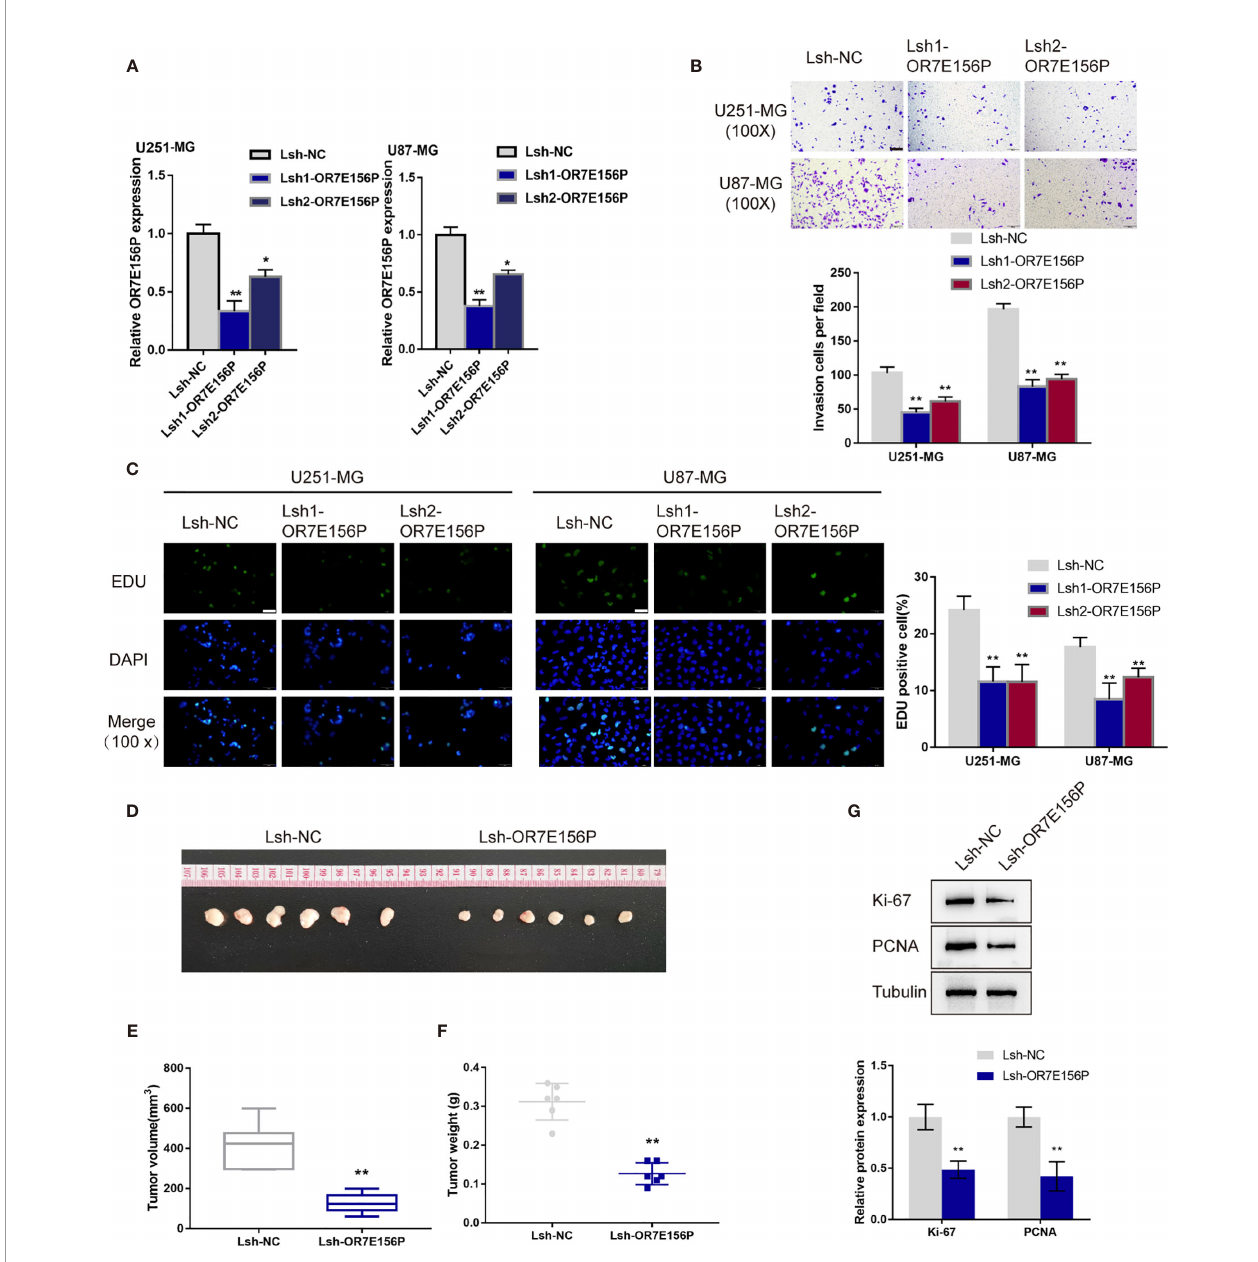
FIGURE 2 | In vitro and in vivo effects of OR7E156P on glioma (A) OR7E156P silencing was achieved in U251-MG and U87-MG cells by infecting cells with lentivirus containing short hairpin RNA for OR7E156P (Lsh1-OR7E156P or Lsh2-OR7E156P). Lsh-NC was infected as a negative control. The silencing ef fi ciency was veri fi ed by qRT-PCR. Then, U251-MG and U87-MG cells were infected with Lsh1-OR7E156P, Lsh2-OR7E156P, or Lsh-NC and examined for cell invasion by Transwell assay (B) ; DNA synthesis capacity by EdU assay (C) . (D) Subcutaneously implanted tumor model was constructed in nude mice by injecting glioma cells infected with Lsh1-OR7E156P or Lsh-NC. (E, F) Tumor volume and tumor weight were examined in each group. (G) The protein levels of Ki-67 and PCNA in tumor tissues were examined by Immunoblotting. * P < 0.05, ** P <